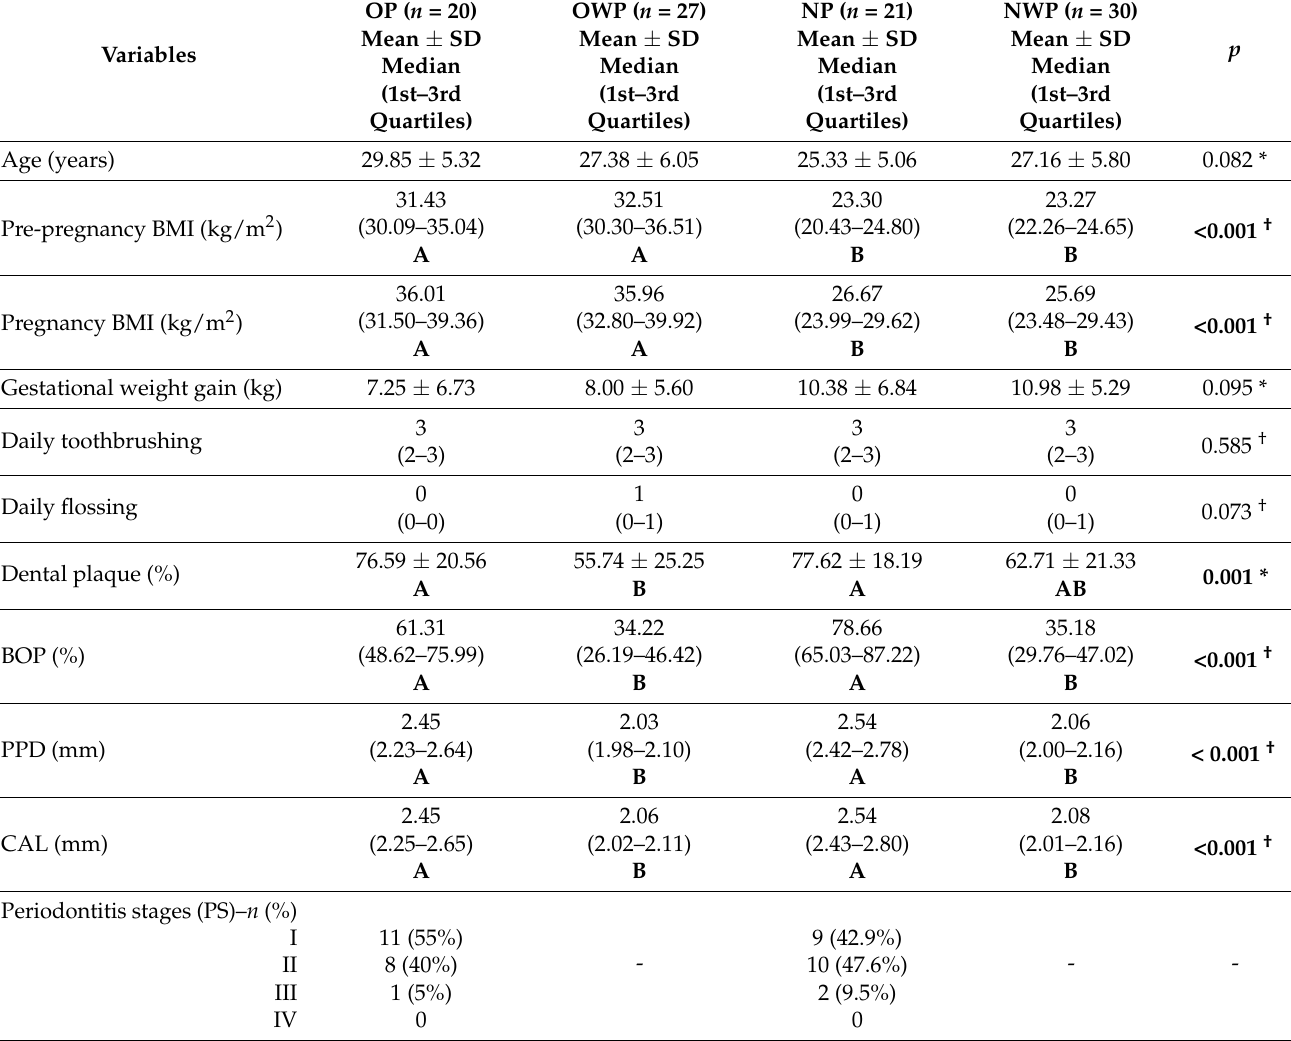
Table 1. Systemic condition, oral hygiene behavior, and periodontal parameters of the